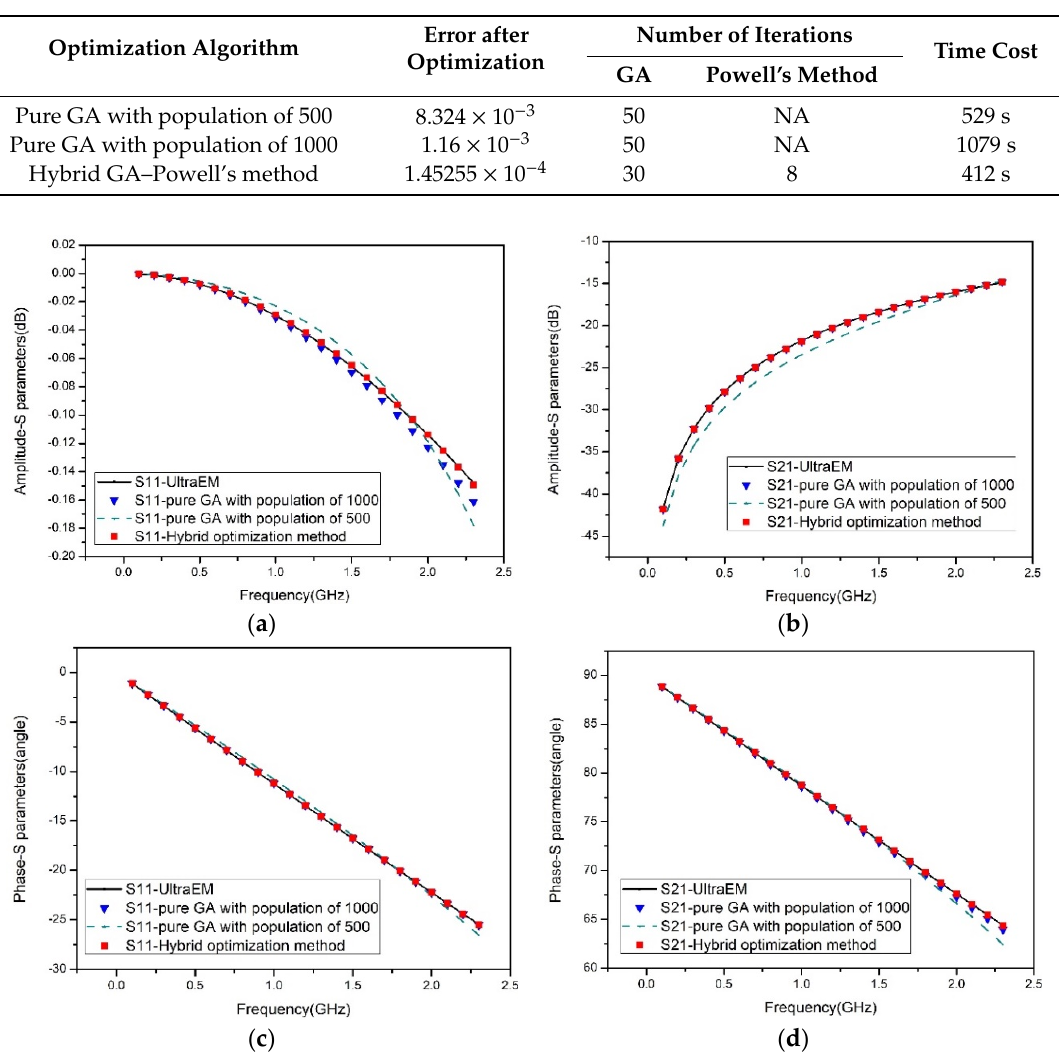
Table 5. Error after optimization, number of iterations and time cost of optimization algorithm with the example of planar spiral inductor.